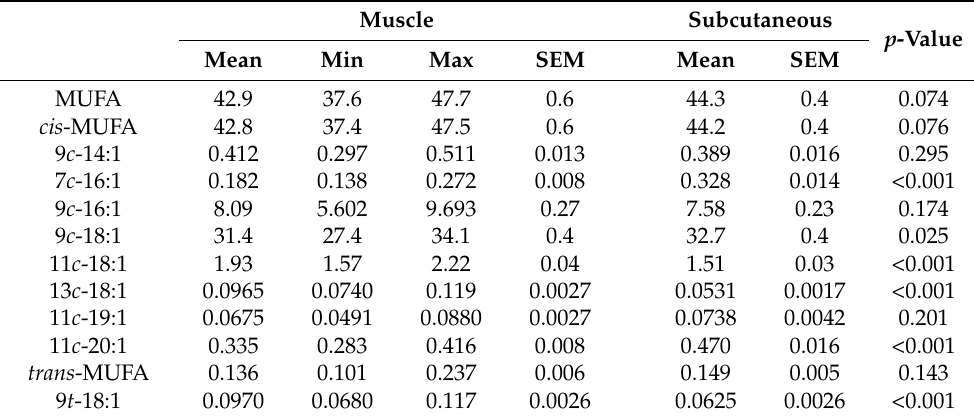
Table 3. Effect of fat tissue (muscle and subcutaneous fat) on the monounsaturated fatty acid composition of horse meat in percentage basis (%) ( n = 20).